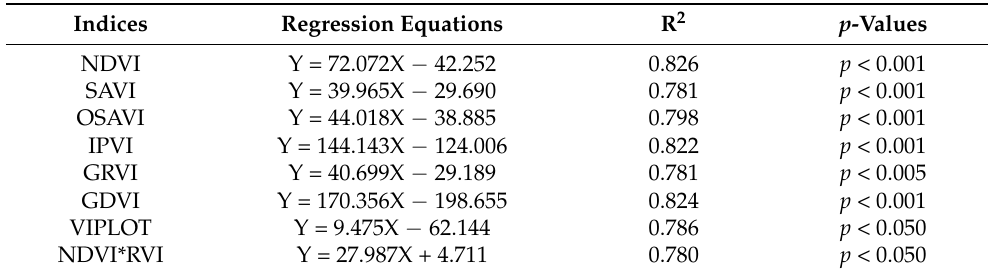
Table 4. The linear regression analysis of multispectral-based VIs and maize grain yields using data of 20 plots during the entire growth